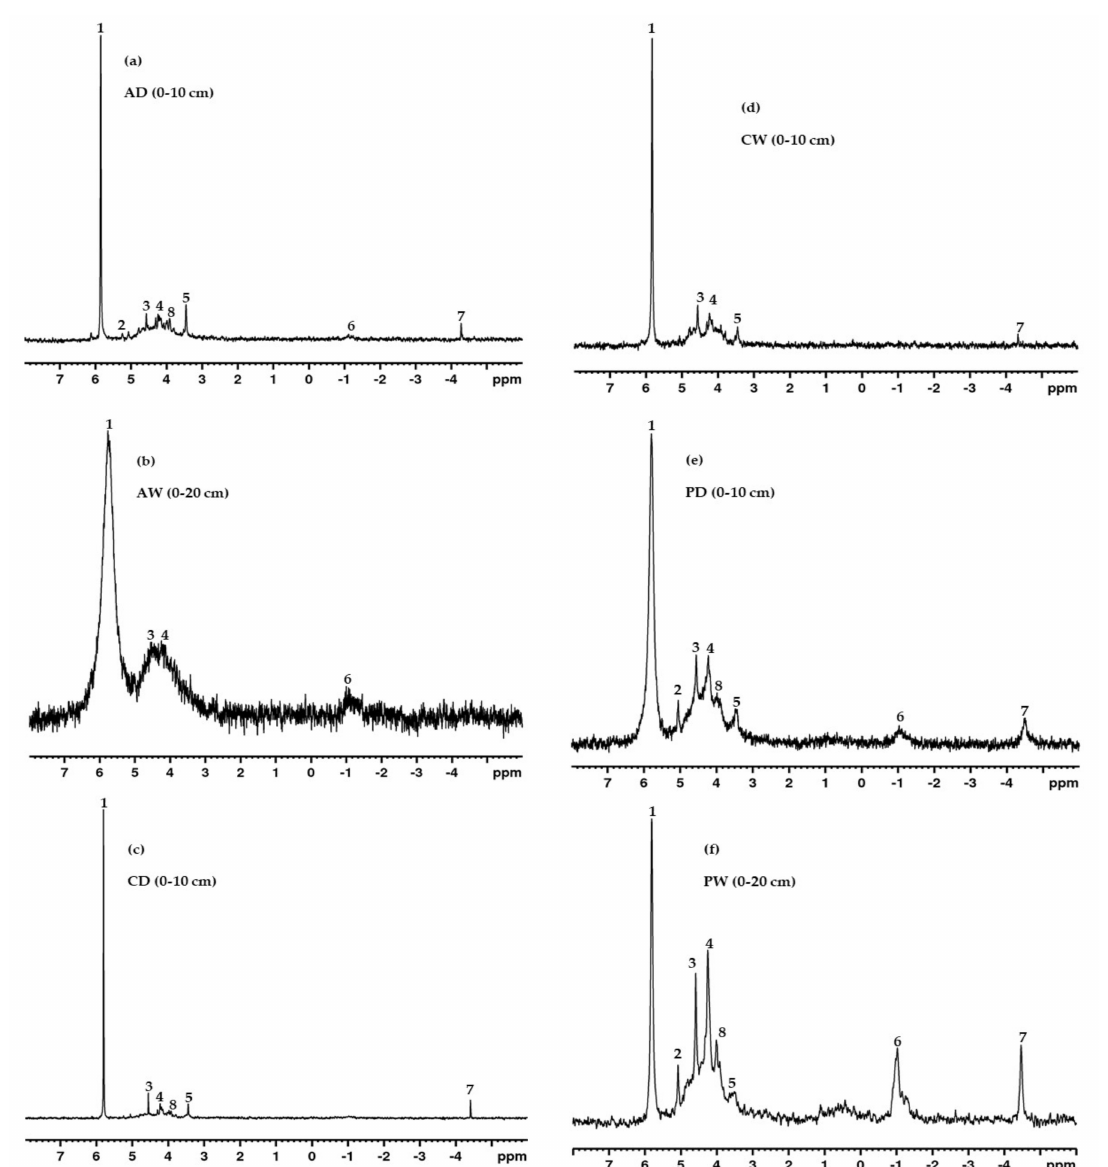
Figure 3. Solution 31 P nuclear magnetic resonance (NMR) spectra of the surface soil horizons of the drained and rewetted peatlands. AD: drained forest peatland, AW: rewetted forest peatland, CD: drained coastal peatland, CW: rewetted coastal peatland, PD: drained percolation mire, PW: rewetted percolation mire. 1: orthophosphate, 2: IHP, 3: α -glycerol phosphate, 4: β -glycerol phosphate, 5: IHP, 6: DNA, 7: pyrophosphate, 8: AMP. The line broadening of (b) was due to the highest concentration Fe in the extracted soil solution (Table 4). Numbers in the parenthesis next to the abbreviation of the site names indicate soil-sampling